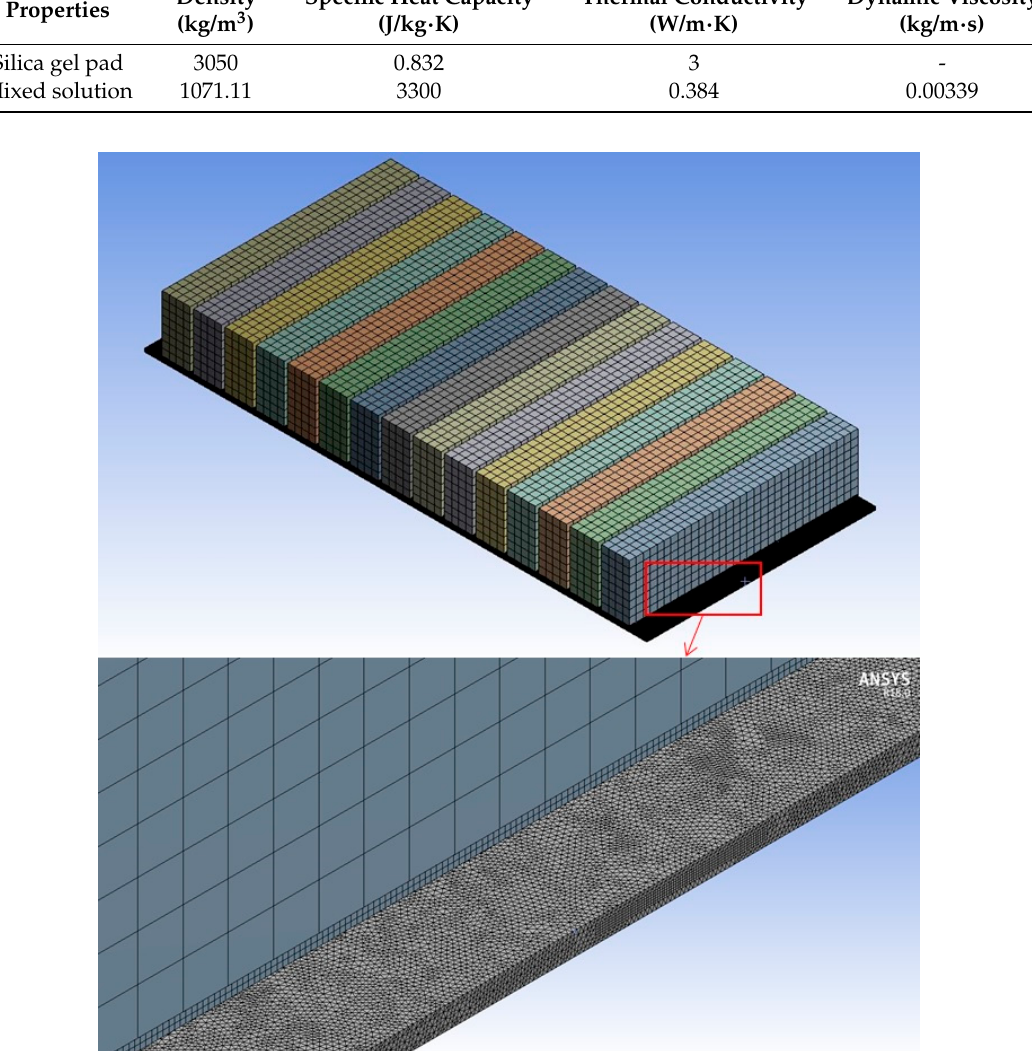
Figure 9. module mesh. Figure 9. Module